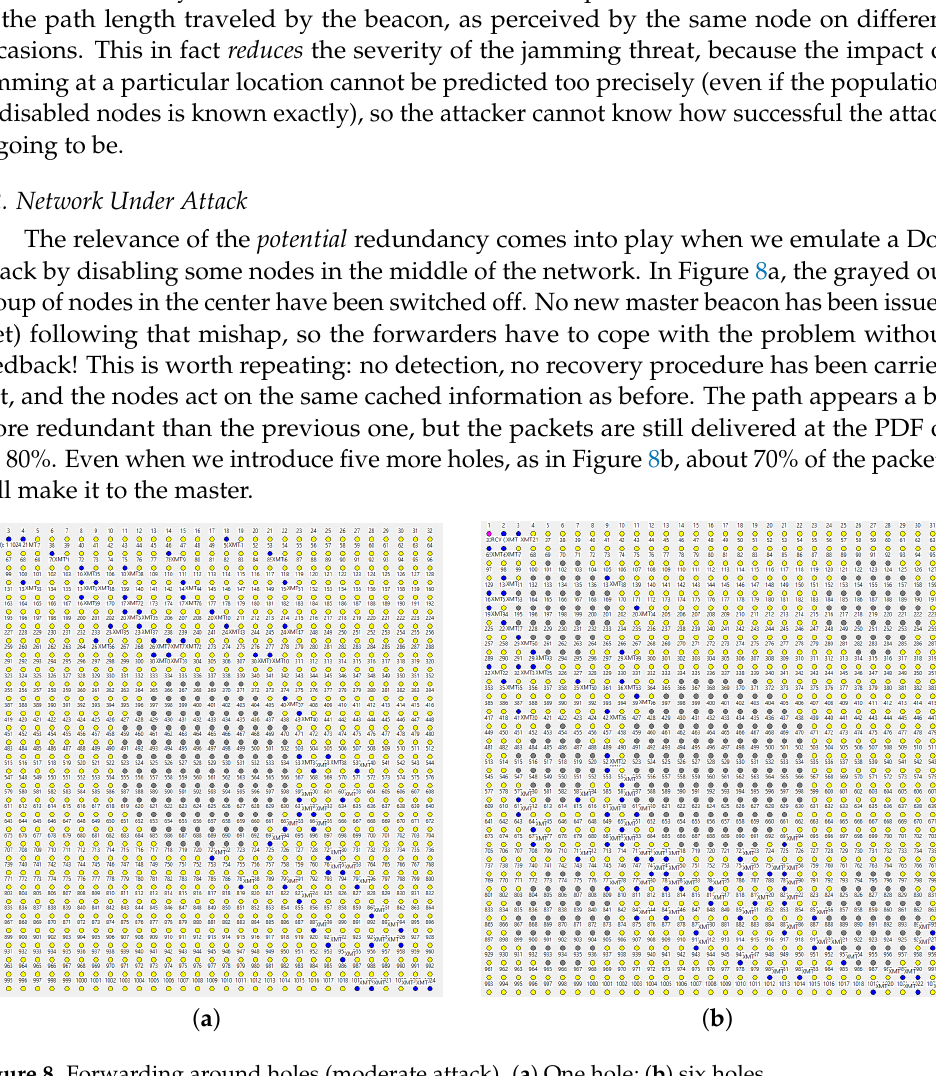
Figure 8. Forwarding around holes (moderate attack). ( a ) One hole; ( b ) six